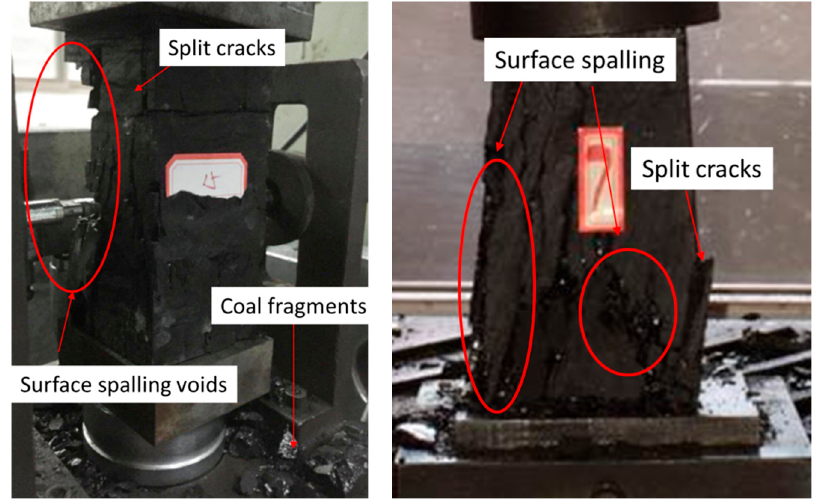
Figure 9. Ultimate failure mode of coal specimens in PJ coal mine.